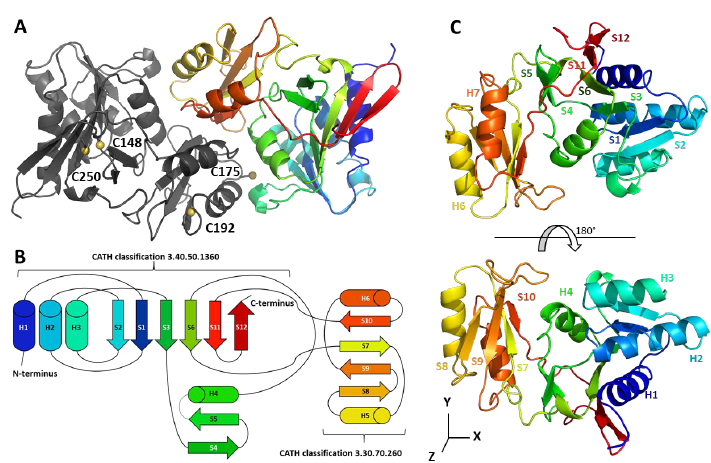
Figure 1. Crystal structure of CrRPI1. ( A ) Cartoon representation of the CrRPI1 crystallographic dimer colored in grey for the first subunit and from blue (N-terminus) to red (C-terminus) for the second subunit. ( B ) Two-dimensional representation of secondary structures of CrRPI1 colored as the second subunit in ( A ). ( C ) Cartoon representation of a CrRPI1 monomer. Two views of the protein are represented as in ( A ) and rotated by 180° on the x -axis. Secondary structures are annotated as in ( A ).